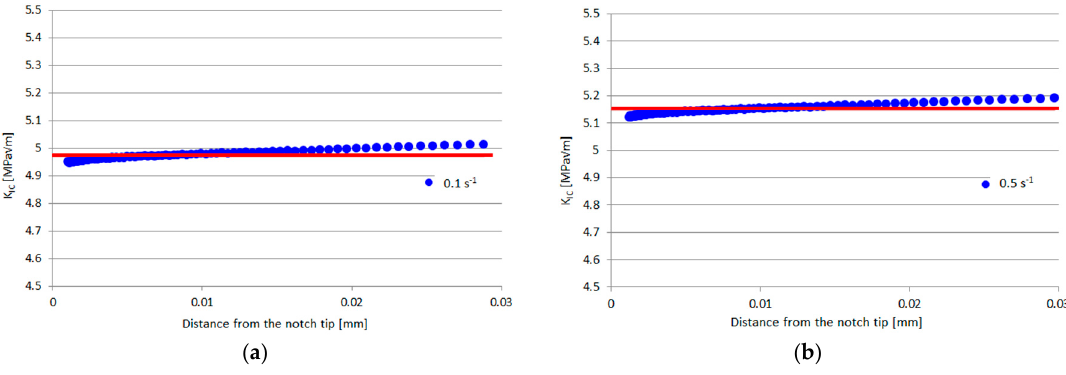
Figure 5. Estimation of the fracture toughness for a strain rate of 0.1 s − 1 ( a ) and 0.5 s − 1 ( b ).